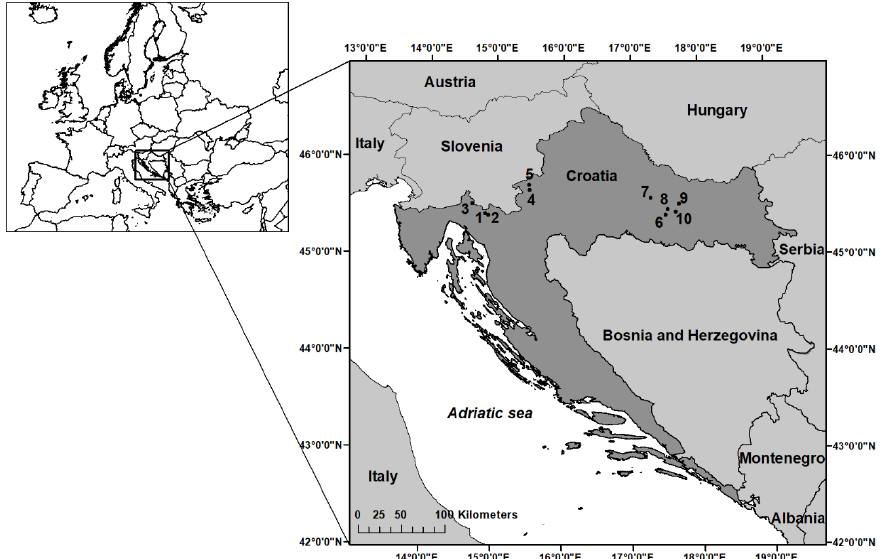
Figure 1. Sampling locations: Gorski Kotar region: 1–Mala Lešnica, 2–Curak; 3–Bresni Potok; Mt. Žumberak area: 4–Kupˇcina, 5–Slapnica; Mt. Papuk area: 6–Orljava, 7–Toplica, 8–Brzaja, 9–Jankovaˇcki potok, 10–Veliˇcanka.